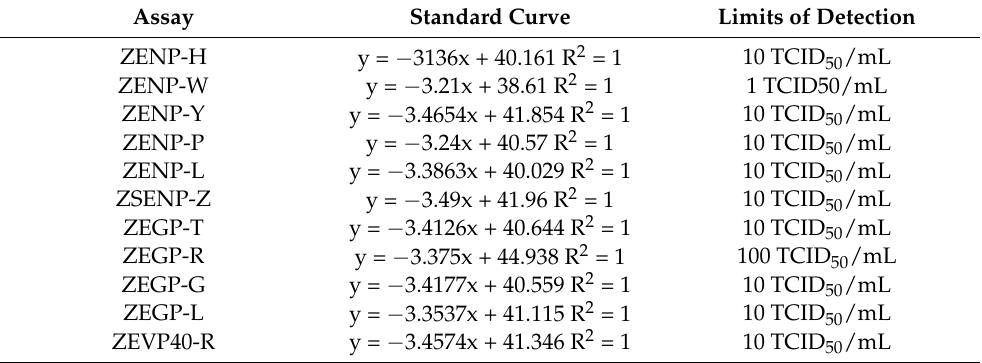
Table 3. The detection limits of the TaqMan RT-PCR assays for EBOV. The sensitivity of EBOV real-time RT-PCR assays was evaluated using viral RNA extracted from serial dilutions of known titre of virus stock. Amplification plots were realized on viral RNA extracted from 10-fold dilutions (10 − 1 ~10 − 7 dilution, i.e., 10 6 ~10 0 TCID50/mL) of virus-infected cell supernatants. Assay Standard Curve